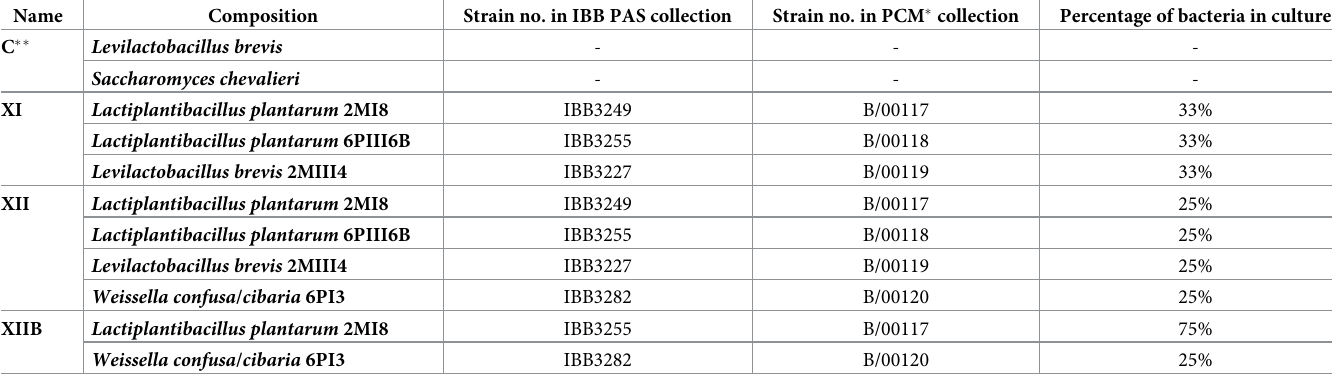
Table 1. Starter cultures’